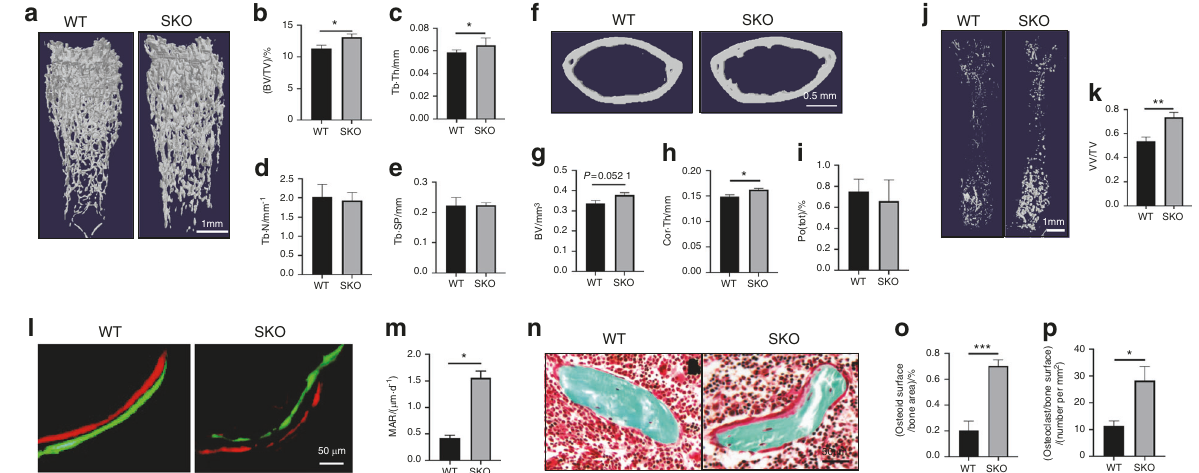
Fig. 1 SKO mice exhibited increased bone formation and decreased bone resorption. a Representative three-dimensional µCT images of the trabeculae in the femurs of 3-month-old WT and SKO mice. Quantitative analysis of the µCT scan in a : b BV/TV percentage bone volume, c Tb. Th trabecular thickness, d Tb. N trabecular number, and e Tb. Sp trabecular separation. f Representative three-dimensional µCT images of the cortical bone in the femurs of 3-month-old WT and SKO mice. Quantitative analysis of the µCT scan in f : g BV bone volume, h Cor. Th cortical bone thickness, i Po (tot) total porosity. j Representative three-dimensional reconstructed µCT-based angiography of vessels in mouse femurs. k Quantitative analysis of vessel volume in j . VV vessel volume, TV tissue volume. l Double labeling of the mineral layers in mouse femur trabecular bone. m Quantitative analysis of the mineral apposition rate in l . n Trichrome staining of mouse femurs. The osteoid layer is labeled red. Quantitative analysis of the osteoid-covered surface ( o ) and osteoblast numbers ( p ). a – p n = 5, * P < 0.05, * P < 0.01, and *** P < 0.000 1 Error bar represents the standard error of the